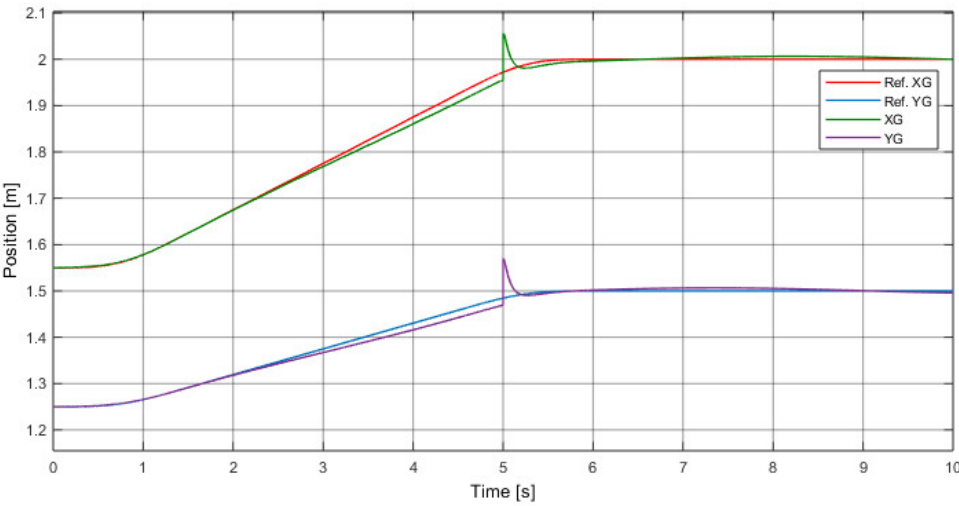
Figure 22. Positioning response of the planar CDPR in the presence of disturbance of a PID controller.